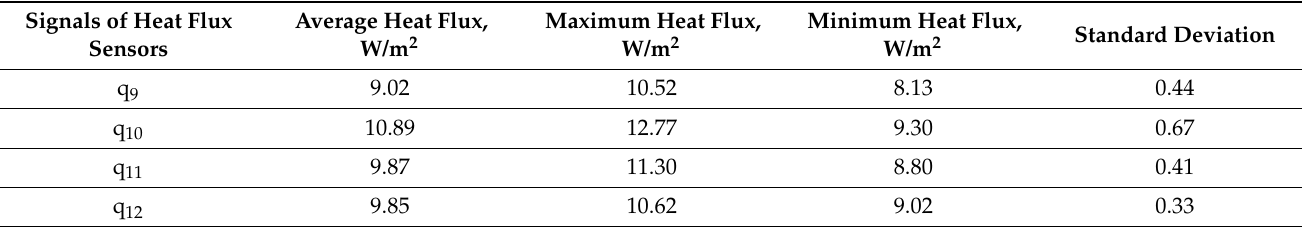
Table 2. Chosen statistical values for the q 9 –q 12 heat flux